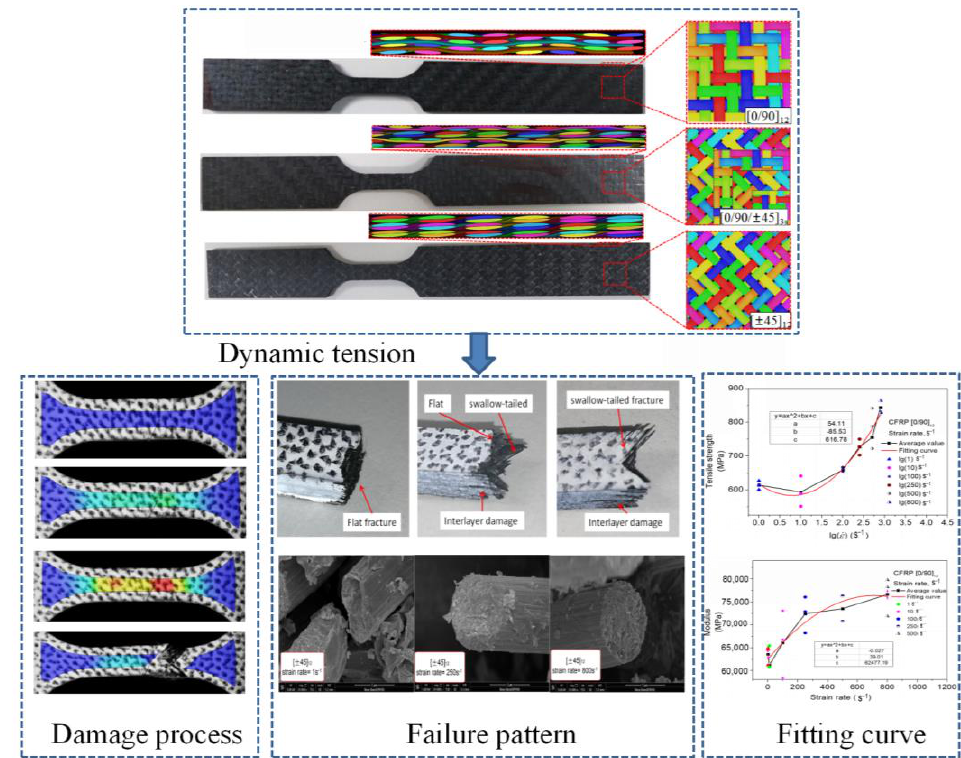
Figure 1. Dynamic tensile test of composite [22].